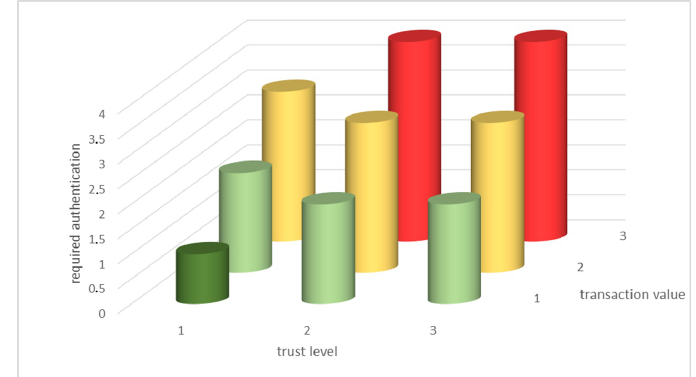
Figure 14. Required authentication procedures by the trust level and transaction